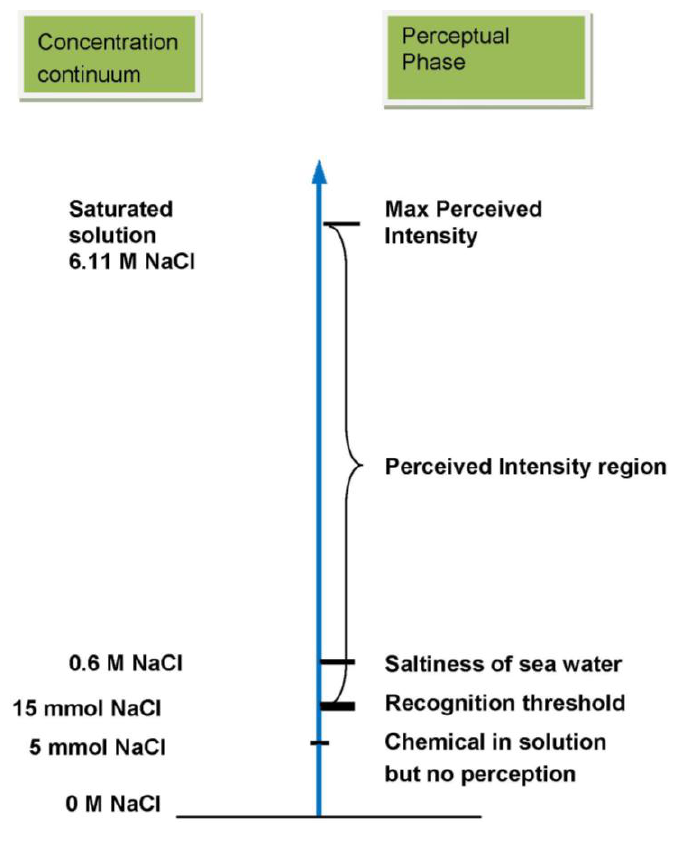
Figure 2. Scale diagram of taste perception as concentration increases (adopted from